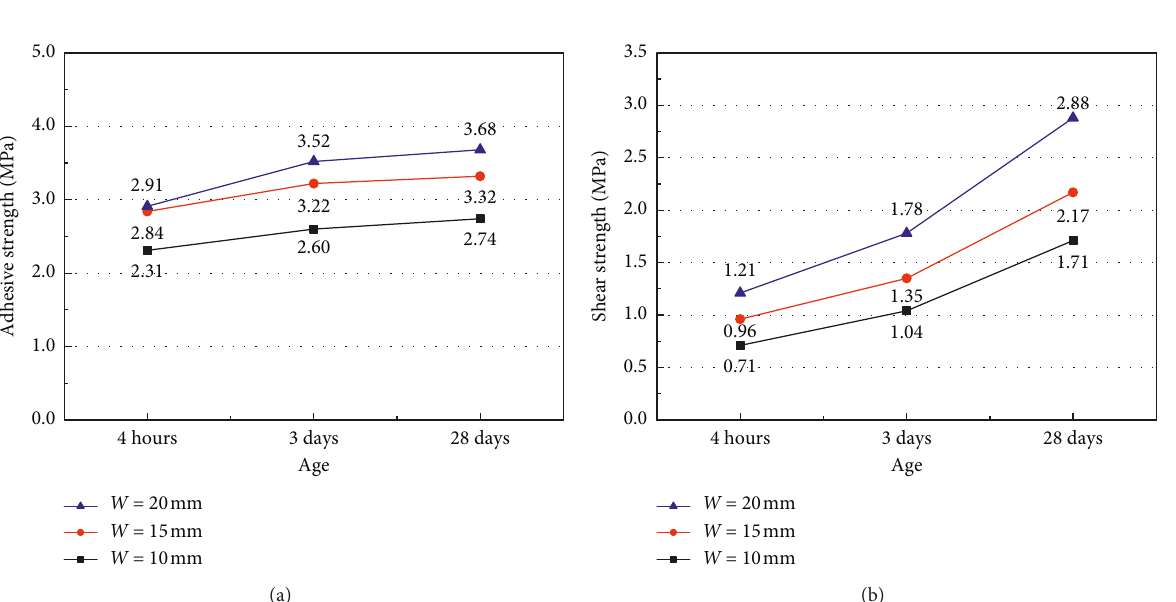
Figure 7: Test outcome of mortar. (a) Compressive strength. (b) Flexural strength.